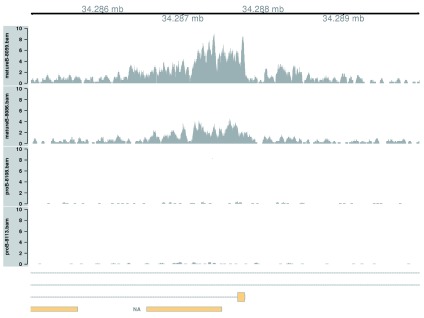
Coverage tracks for a simple DB event between pro-B and mature B cells, across a broad region in the H3K9ac data set.Read coverage for each library is shown as a per-million value at each base.